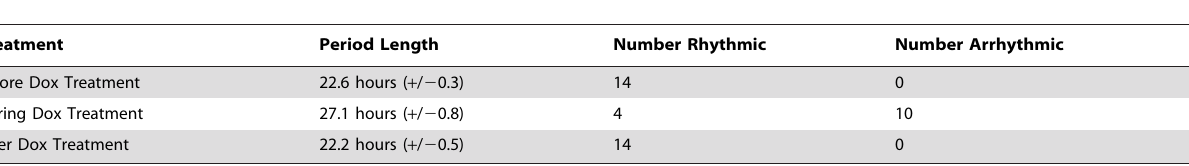
Table 1. Clock expression via the tet-OFF system reversibly rescues normal circadian rhythmicity in DD ( + / 2 standard deviation).